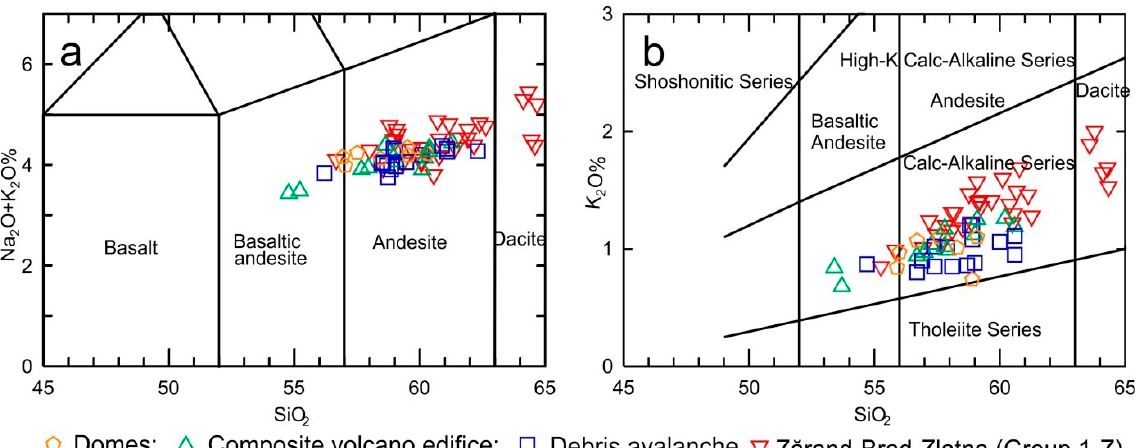
Figure 9. ( a ) Total alkali vs. Silica (TAS) diagram [49] and ( b ) K 2 O vs. SiO 2 [50] for Bont ă u volcanic complex, new data, and Group 1 ‐ Z rocks [3]. All the new data are included in Supplementary Tables S1 and S2.